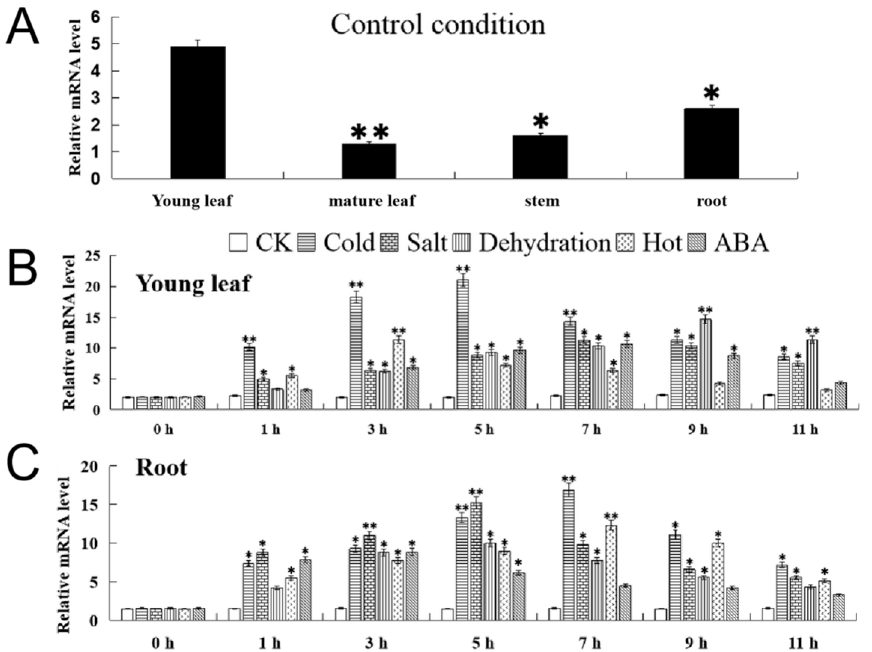
Figure 4. Real-time expression of FvMYB114 gene. ( A ) The expression level of FvMYB114 in young leaves, mature leaves, stems and roots. ( B , C ) Expression of FvMYB114 in young leaves and roots after different times and treatments. The standard deviation is indicated by an error line. An asterisk indicates that there is a significant difference (SD) between the treatment group and the control group, * p ≤ 0.05, ** p ≤ 0.01, Student’s t -test.